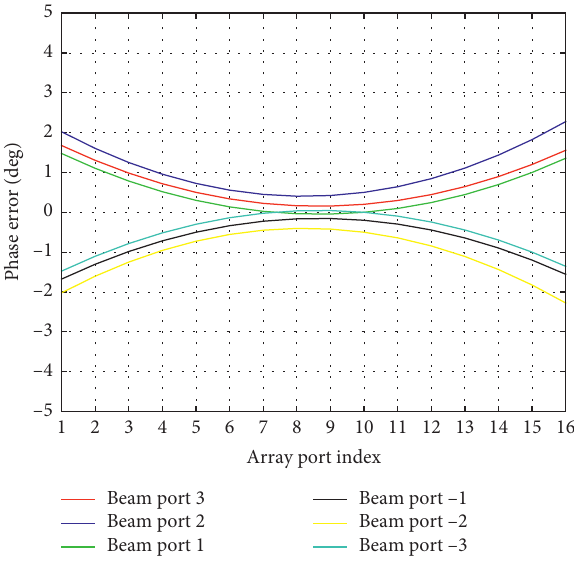
Figure 22: Array port phase errors.